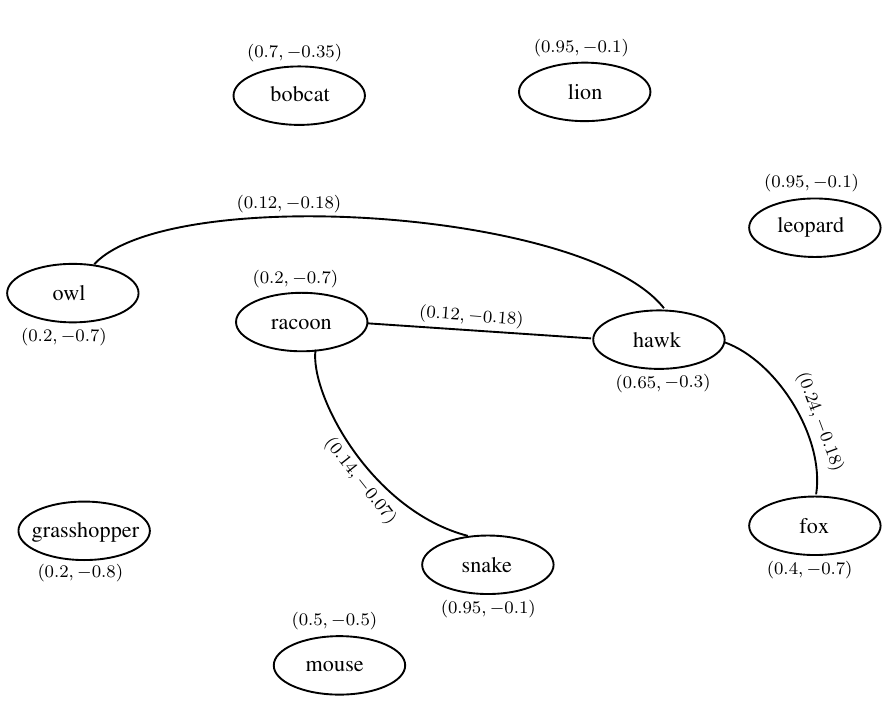
Figure 7. Bipolar fuzzy competition common enemy graph. Figure 2.7: Bipolar fuzzy competition common enemy graph